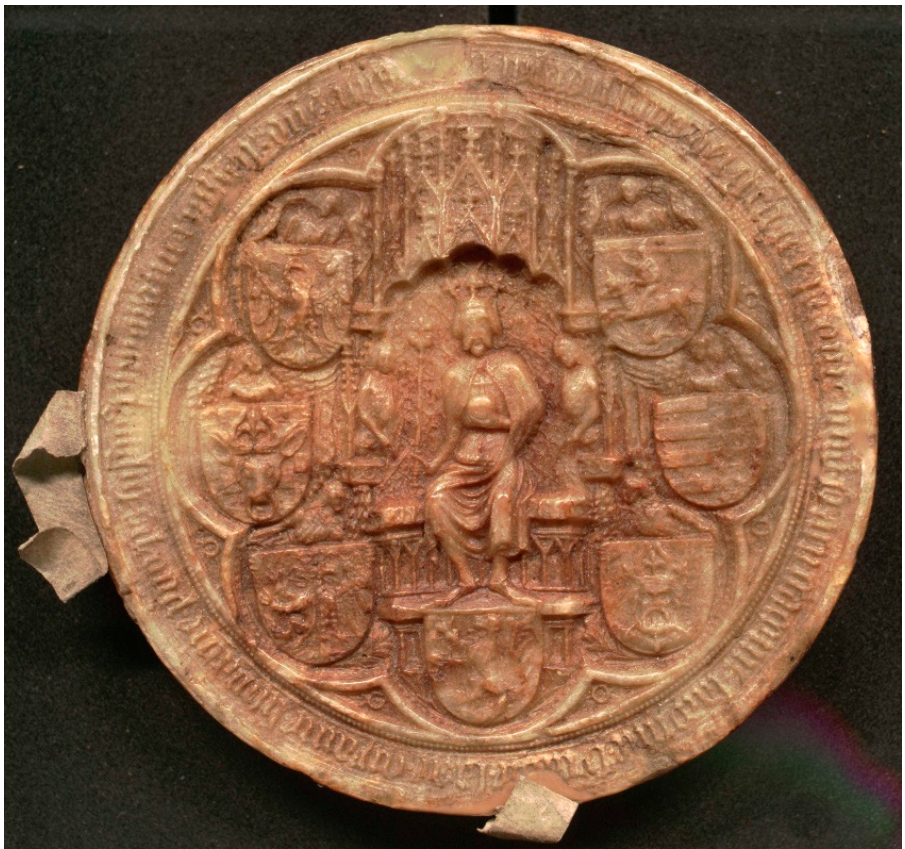
Figure 1. Great Seal of majesty of Ladislaus Jagiełło, impression in wax, Archiwum Gł ó wne Akt Dawnych (The Central Archives of Historical Records in Warsaw), Zb. Dok. perg. 36, image published in: https://agad.gov.pl/?page_id=972 ( accessed on 9 February 2022) .